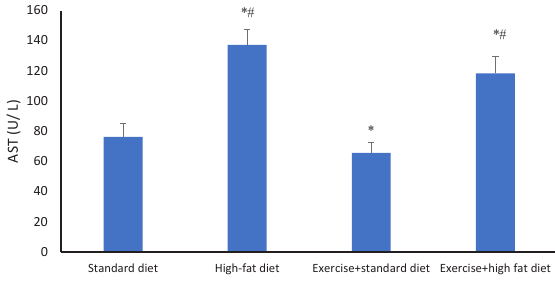
Figure 3. AST levels among groups. Note . AST: Aspartate amino- transferase. * Indicates a significant difference with the group receiving a standard diet ( P < 0.05). # Denotes a significant difference with exercise + standard diet ( P <